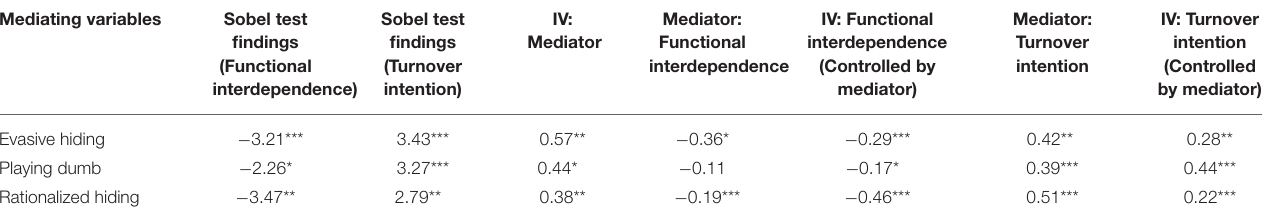
TABLE 3 | Mediating role of dimensions of knowledge-hiding behavior on the association between workplace incivility and functional interdependence, turnover intention. Mediating